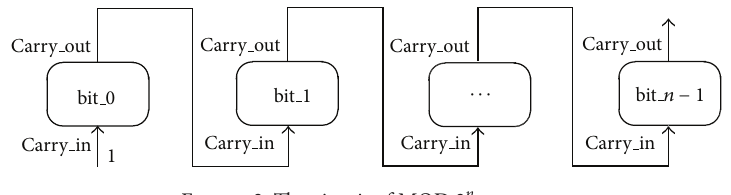
Figure 2: The circuit of MOD 2 𝑛 counter. Table 2: Comparison of ETL 𝑓 and ETL 𝑙+𝑓 with periodicity